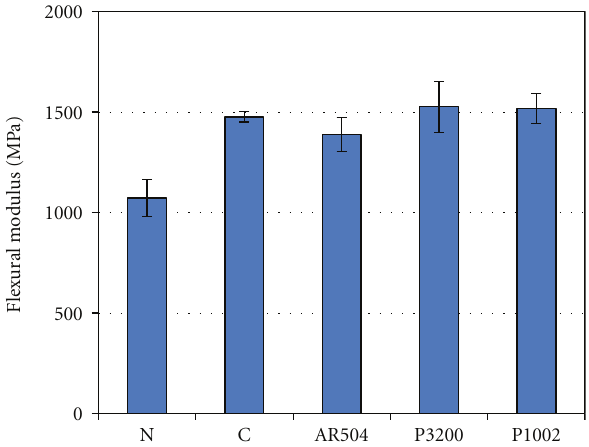
Figure 4: Comparison of flexural modulus for neat and sunflower hull-reinforced polypropylene with and without the inclusion of chemical compatibilizers.